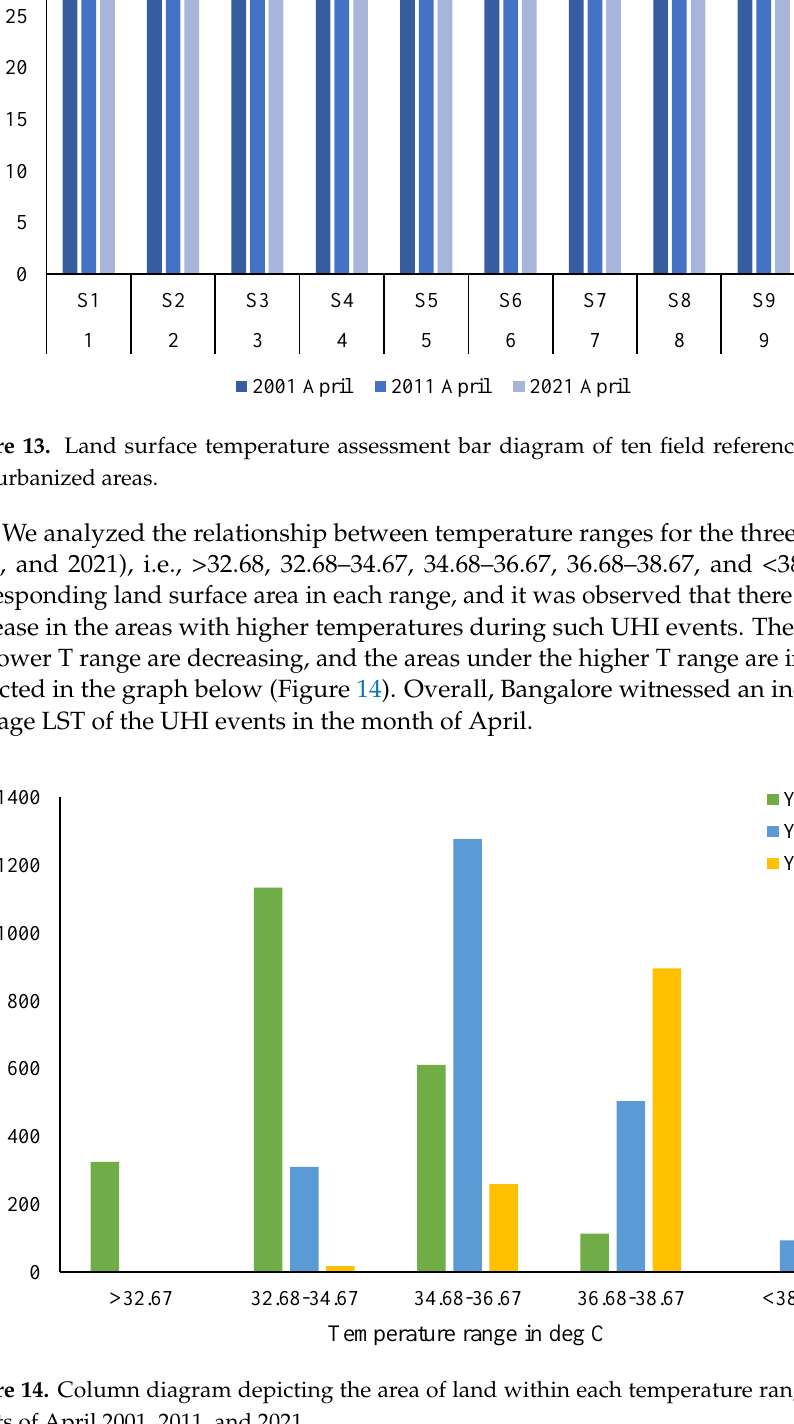
Figure 14. Column diagram depicting the area of land within each temperature range of the UHI events of April 2001, 2011, and 2021.